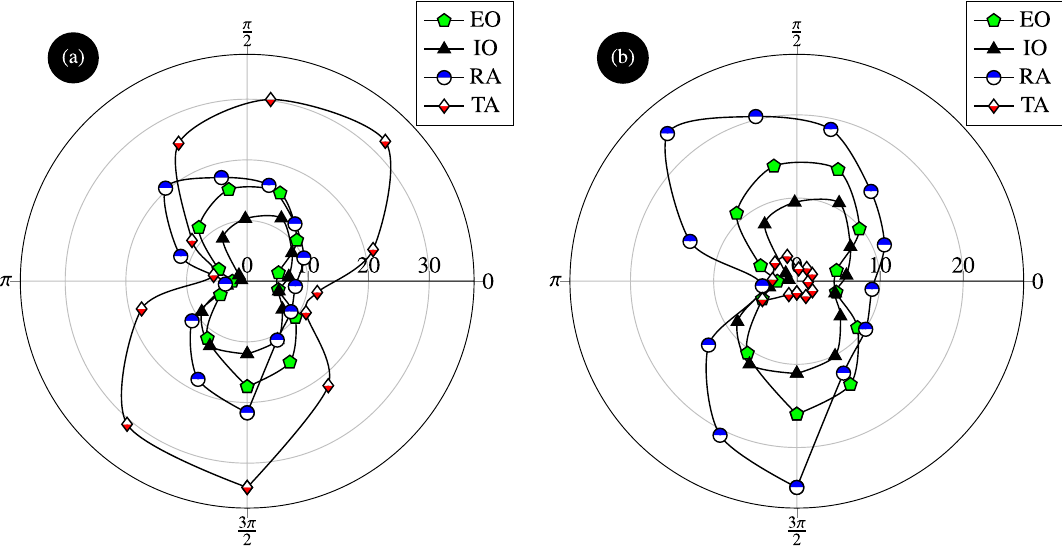
Figure 7. Distributions of equivalent stress (expressed in kPa) in the AW muscles affected by hernia ( a ) without reinforcement and ( b ) when a surgical mesh implant is used to reinforce the transversus abdominis. Hernia repair by mesh reinforcement reduces the magnitude of stresses and relieves their concentration.